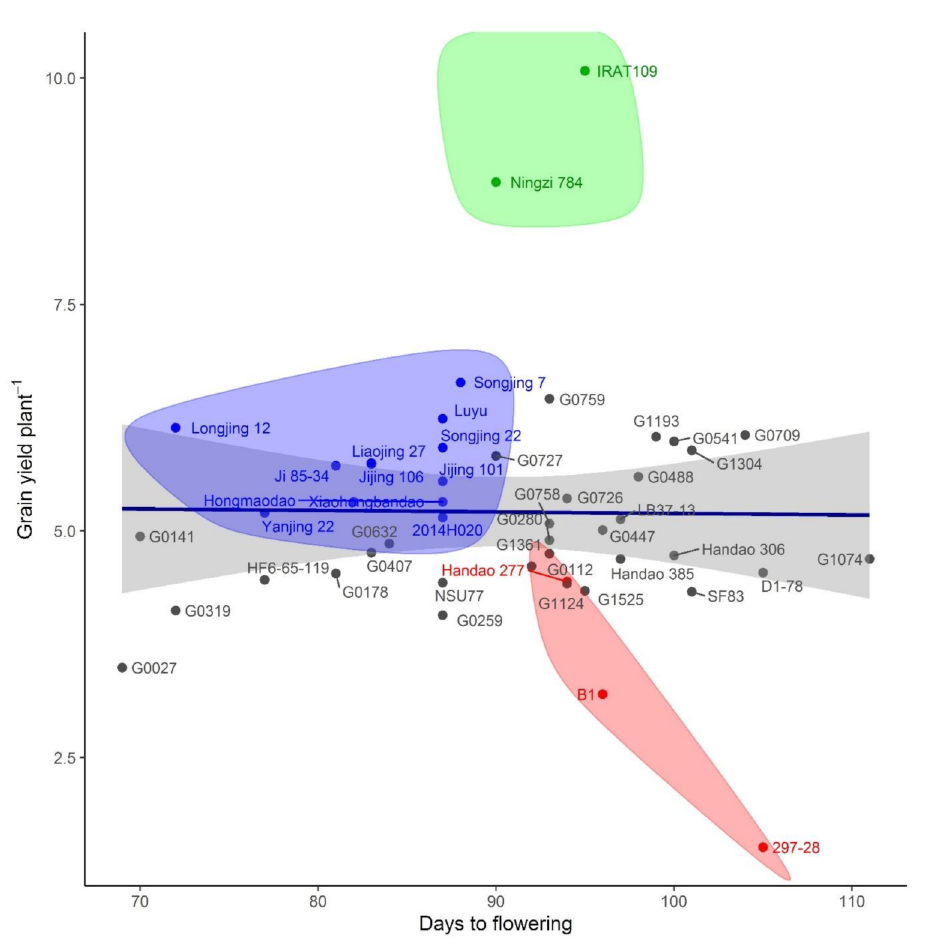
Figure 5. Scatter diagram based on grain yield plant − 1 (g) versus days to flowering distribution of 45 genotypes including controls (indicated within red circle). Note: two genotypes in the green circle were marked as prime genotypes. The genotypes in the blue circle were characterized by better grain yield along with the shorter growth duration. All encircled genotypes are presented with their names, whereas most of the remaining entries are symbolized by their accession